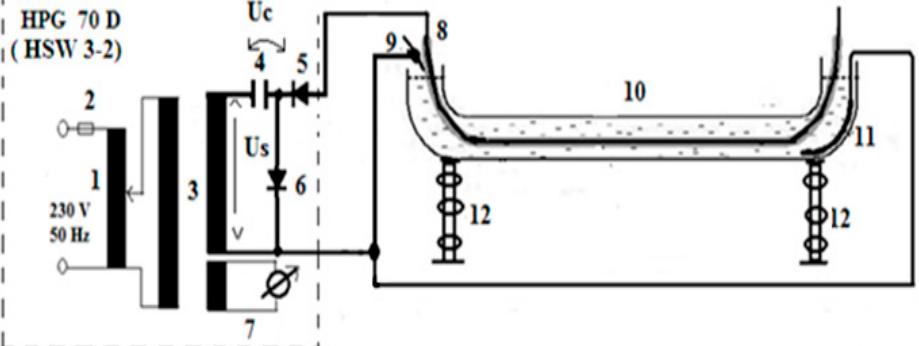
Figure 2. The interface of the command and measuring panel.